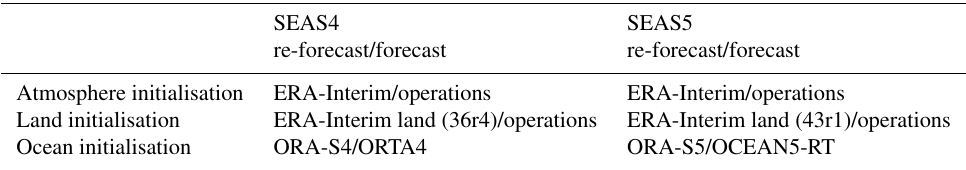
Table 2. Table summarising the initialisation of SEAS4 and SEAS5. Abbreviations are defined in the text. SEAS4